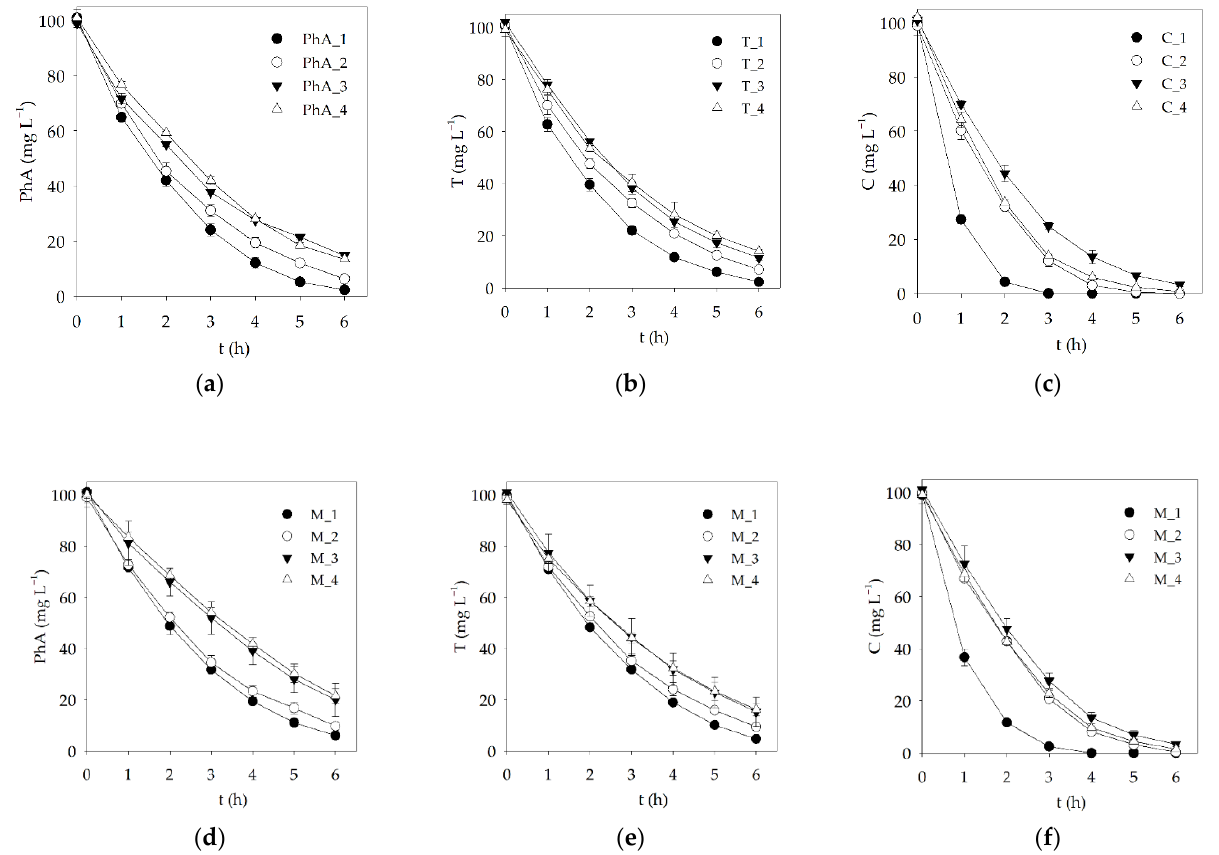
Figure 1. Decay in time of phthalic acid, tyrosol, or catechin concentrations during EO experiments ( j = 300 A m −2 ) performed with synthetic samples with different compositions: ( a ) PhA in PhA_1 to PhA_4; ( b ) T in T_1 to T_4, ( c ) C in C_1 to C_4; ( d – f ) PhA, T and C, respectively, in mixtures of PhA + T + C.